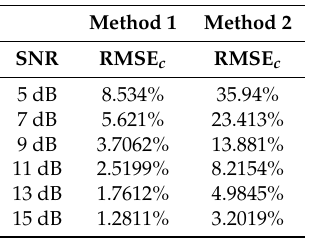
Table 2. Root mean square error (RMSE) of c 1 versus SNR when L = 500.